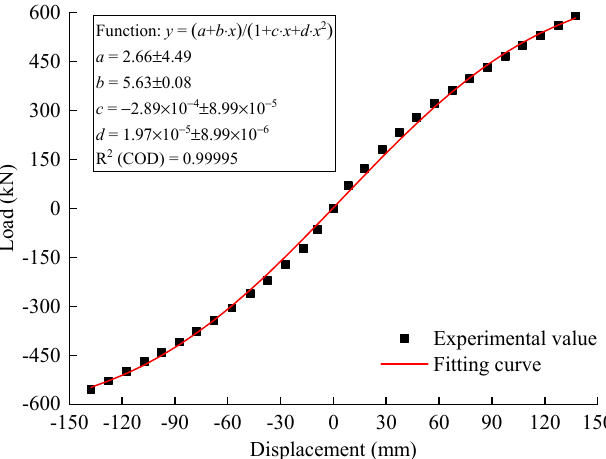
Figure 12. The fitting result of the skeleton curve for the BFRPC composite column.